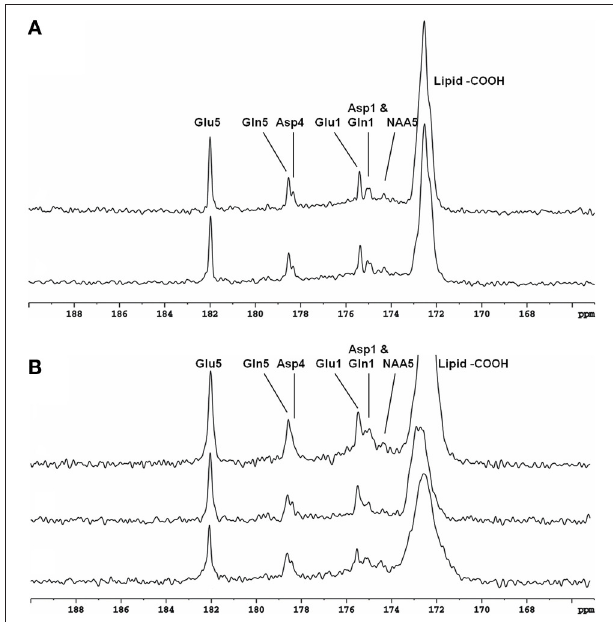
FIGURE 4 | Spectra obtained from occipital lobe of two healthy volunteers (A) and from frontal lobe of three healthy volunteers (B) at 3 Tesla. A volume coil was used for stochastic proton decoupling in this study. Acquisition parameters were: number of data points 2,048, NS 384, TR 4s. Adapted from Li et al. [